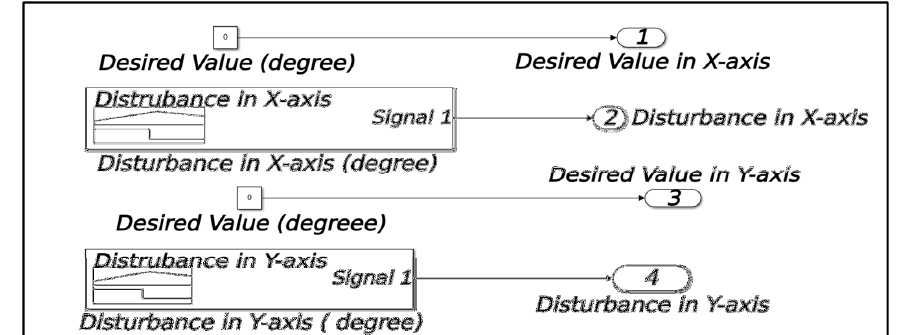
Fig. 2. Input parameters